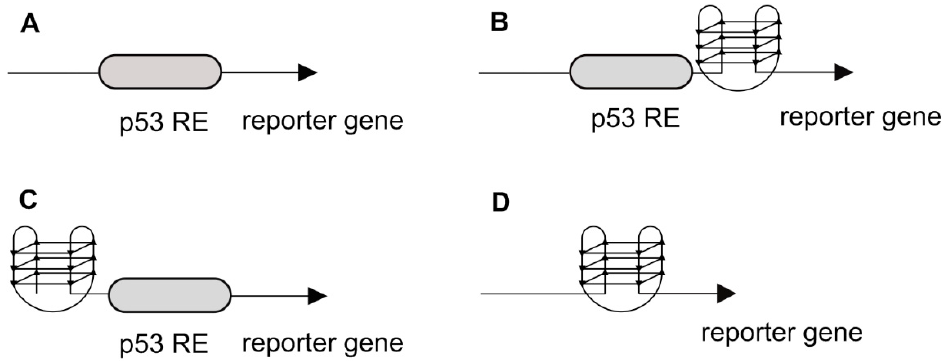
Figure 2. Scheme of the tested sequences in the luciferase reporter promoter region .